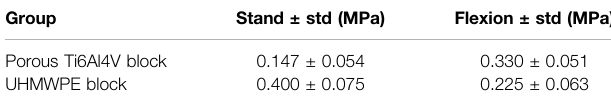
TABLE 4 | Average Von Mises stress (MPa) of ROI. Group Stand ± std (MPa) Porous Ti6Al4V